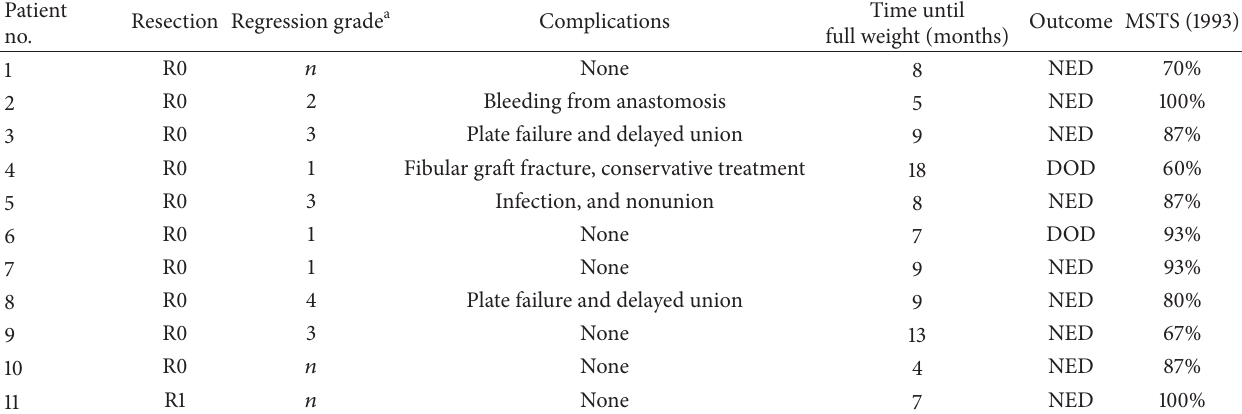
Table 2: Results after tumor resection and reconstruction with a bilateral fibular graft ( 𝑛 =